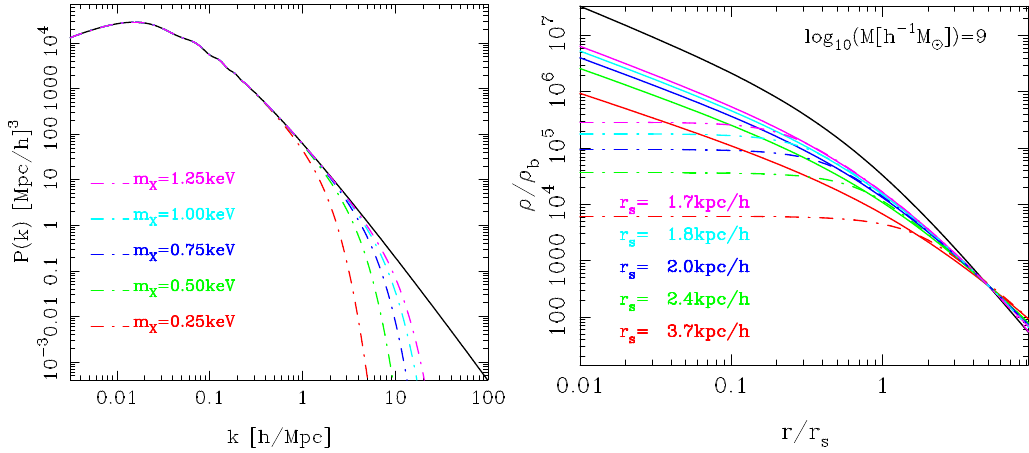
Figure 17. Left panel : comparison of the linear matter power spectrum as a function of wavenumber in the WDM and CDM scenarios. The solid black line shows the CDM model. The dot-dashed lines represent the WDM power spectra for different values of the particle mass. Right panel : density profiles of CDM and WDM halos with mass: M = 10 9 M (cid:12) . The black line shows the CDM profile; the red, green, blue, cyan, and magenta lines show the WDM profiles for particle mass 0.25, 0.5, 0.75, 1.0, and 1.25 keV, respectively. The solid colored lines show the case where there are no thermal relic velocities; the dot-dash lines denote the case where it is assumed the existence of a relic thermal velocity distribution for the WDM particles. In the panel, it is indicated the scale radius of the halo for the various WDM particle mass considered. The figure is reproduced from